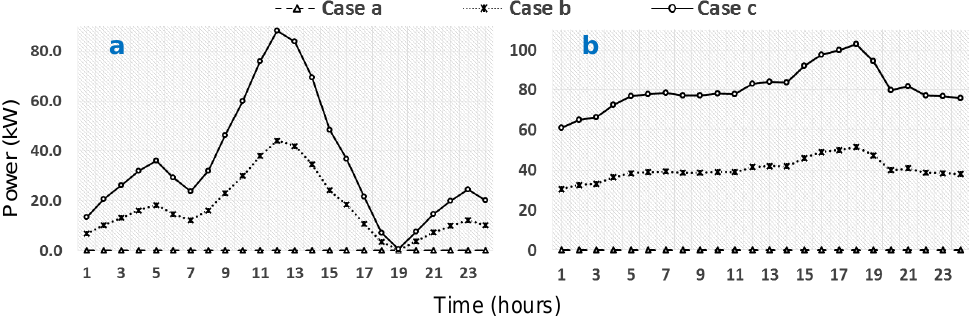
Figure 5. Hourly collective uncertainty gap: ( a ) Renewable energy sources; and ( b ) Electric loads.